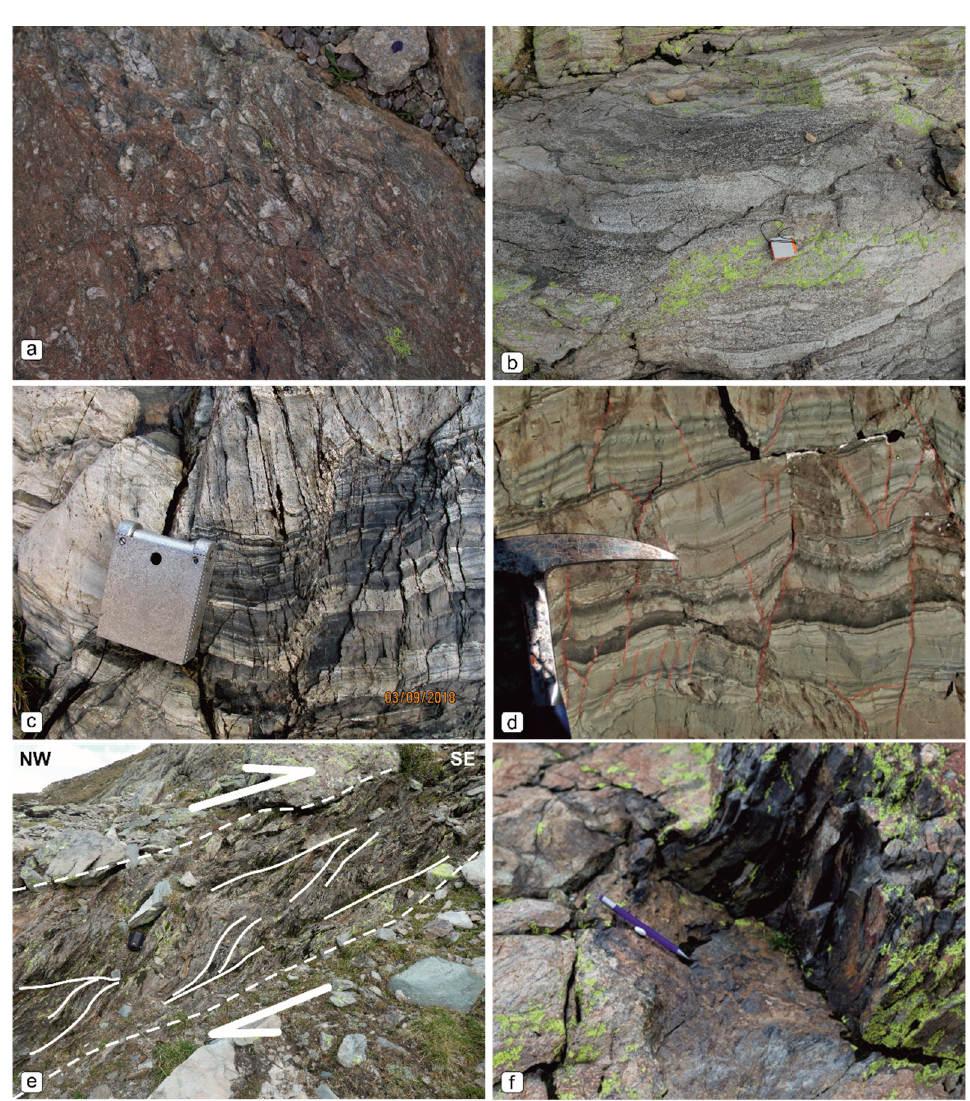
Figure 5. ( a ) Field aspect of the Aga Conglomerate, with pebbles chiefly made of paragneiss, mica schists and polycrystalline quartz; ( b ) The typical banded texture of the “Morbegno Gneiss” rich in albite peciloblasts. Syn-sedimentary normal faults within volcaniclastic sandstones of the upper part of the Mt. Aga Conglomerates to the north ( c ) and southeast ( d ) of the Forcellino Pass. These faults show very similar features with the syn-sedimentary faults described in the nearby Cima Aga area (Figure 2) in the hanging wall of the same LANF [9]. ( e ) S-C structures developed within Aga conglomerates along the Alpine thrusts. ( f ) Alpine cleavage affecting a black tourmalinite layer within the fault